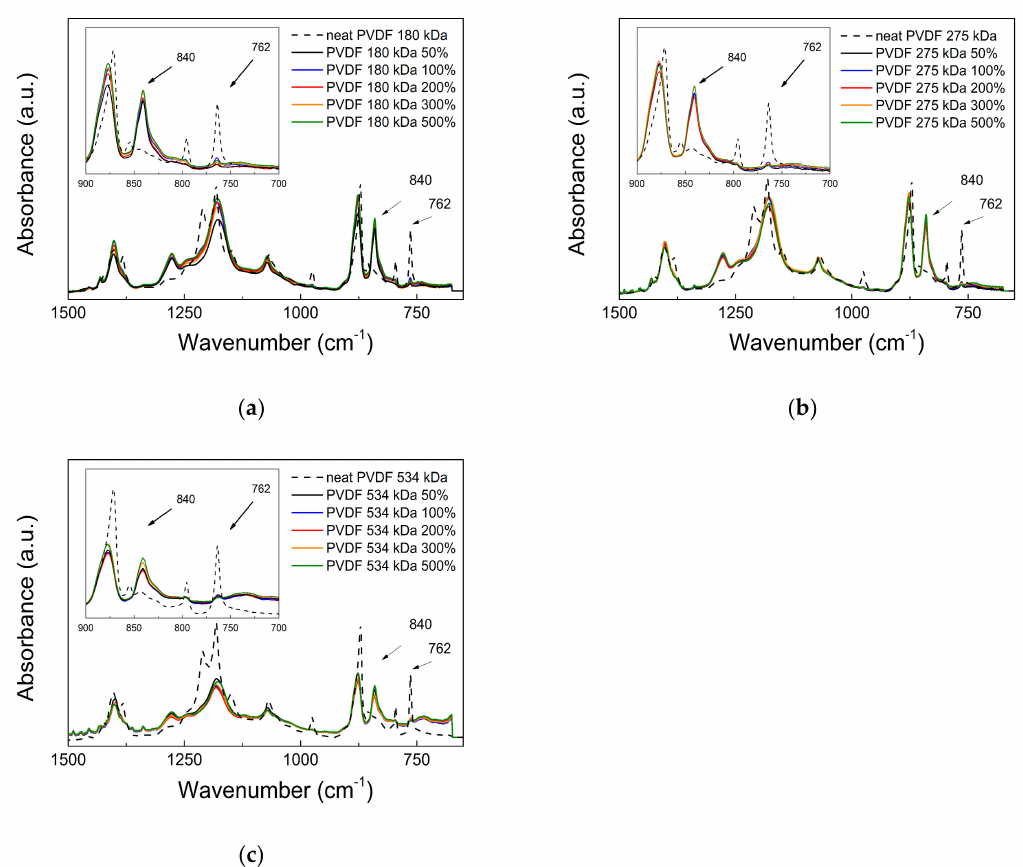
Figure 2. FTIR spectra of the selected samples with initial thickness of 0.5 mm and various molecular weights ( a )180 kDa ( b ) 270 kDa ( c ) 534